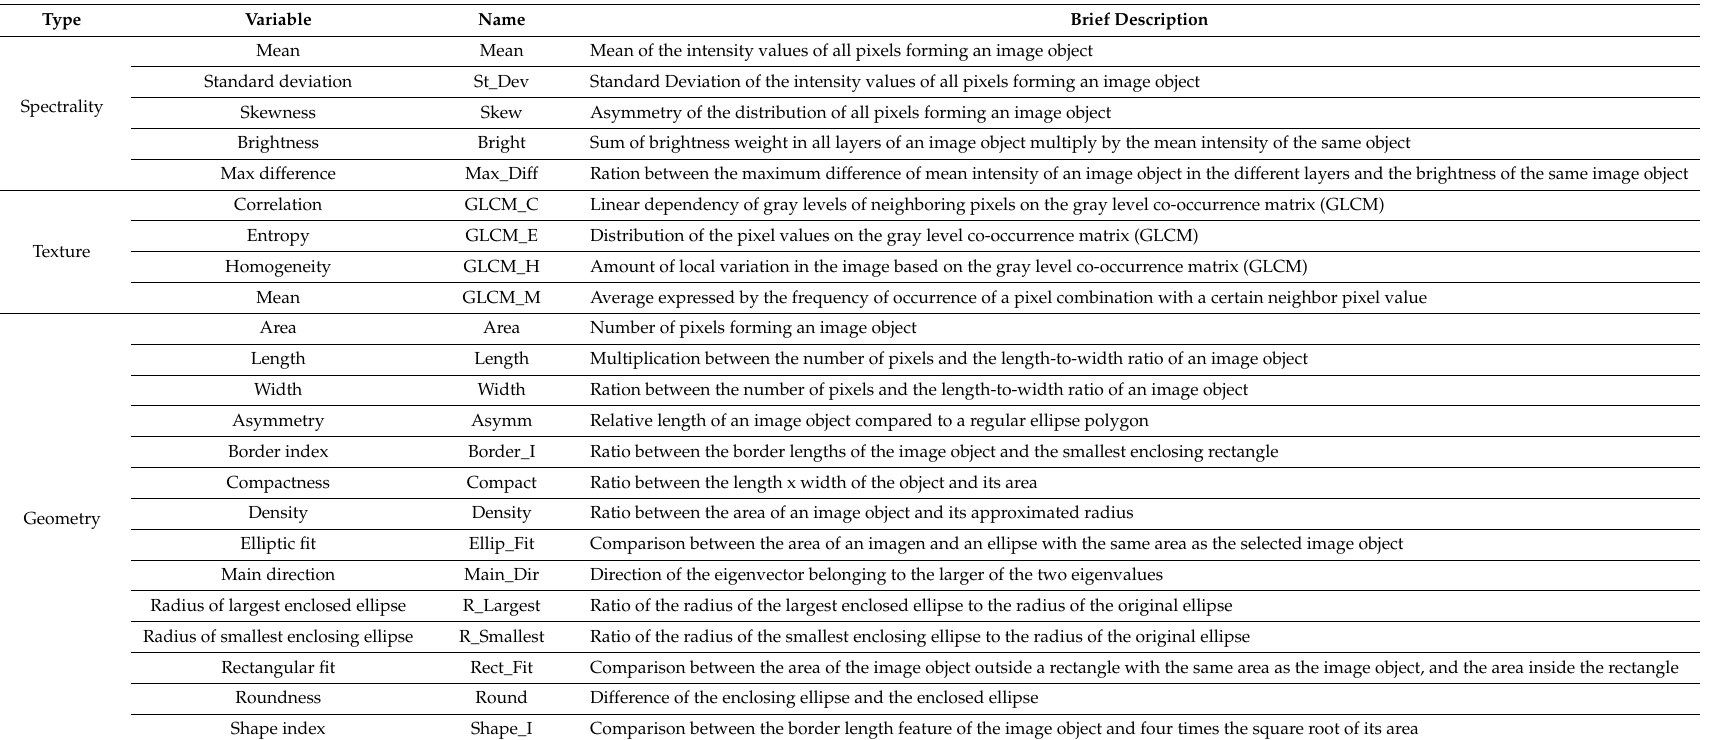
Table 2. Advanced object-based variables derived from segmentation of Landsat 8